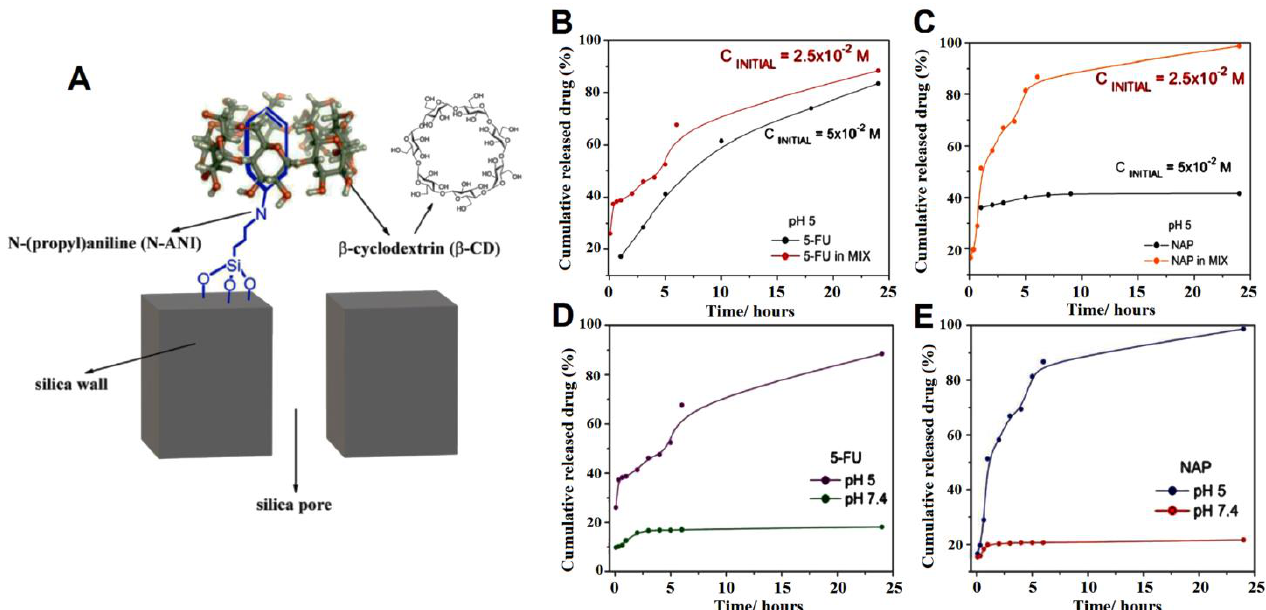
Figure 2. Gatekeeper interaction with silica surface and its effect on drug release in the single or co-loaded matrix. ( A ) β-cyclodextrin non-covalent interaction with N-ANI. ( B ) 5FU individual release rate comparison with mix release at pH 5. ( C ) NAP individual release rate comparison of mix release at pH 5. ( D ) 5FU release rate at pH 5 and 7.4. ( E ) NAP release rate at pH 5 and 7.4. Reproduced from Beňová et al. [100] with permission from Elsevier.